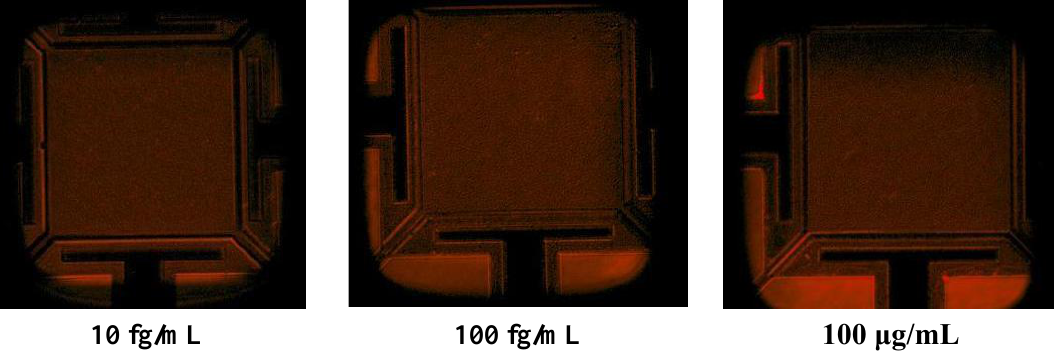
Figure 3. Flourecent micoscopy images of the resonators after streptavidin immobilization. The resonators are coated with different streptavidin concentrations and imaged separately using a same combination of excitation and emission